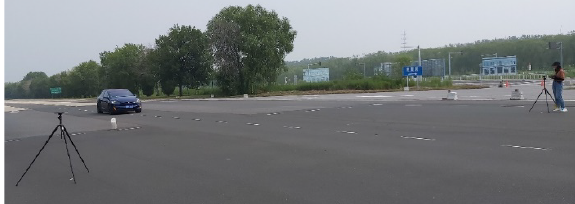
Fig. 1. Site photo of pass-by noise